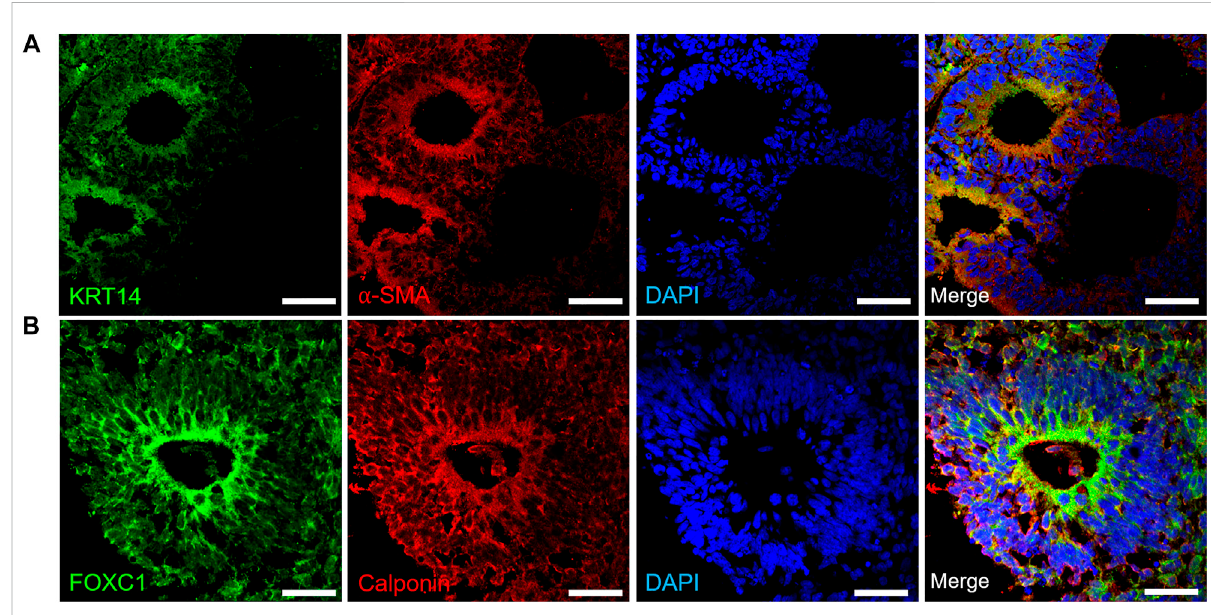
FIGURE 3 Expression ofearlylacrimalgland myoepithelialmarkers intheproteinlevel (A) KRT14+/ α SMA+ lacrimal glandmyoepithelial cells onday30 (B) FOXC1+/Calponin + lacrimal gland myoepithelial cells on day 35 (Figures are representative of three independent differentiation experiments, scale bar: 40 μ